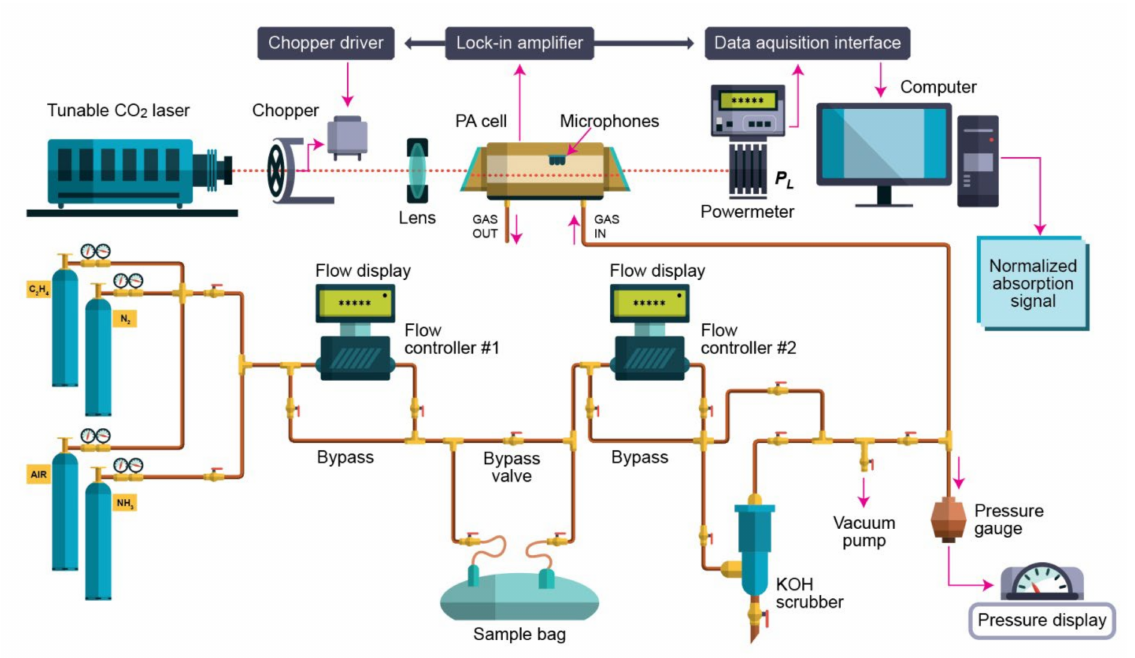
Figure 4. Spectroscopic set-up used for the evaluation of carbon dioxide and ethylene from the respiration of people wearing a surgical